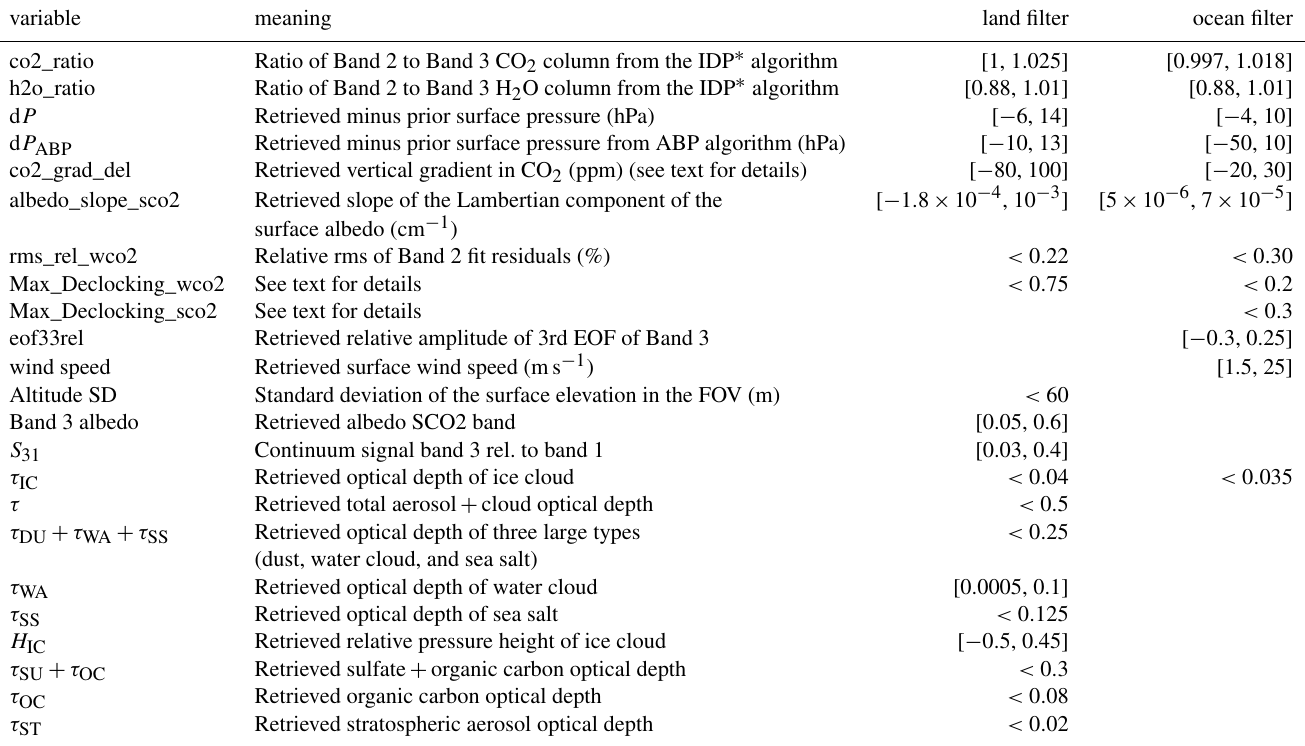
Table A1. X CO quality flag definition for version 8. 2 variable meaning land filter ocean